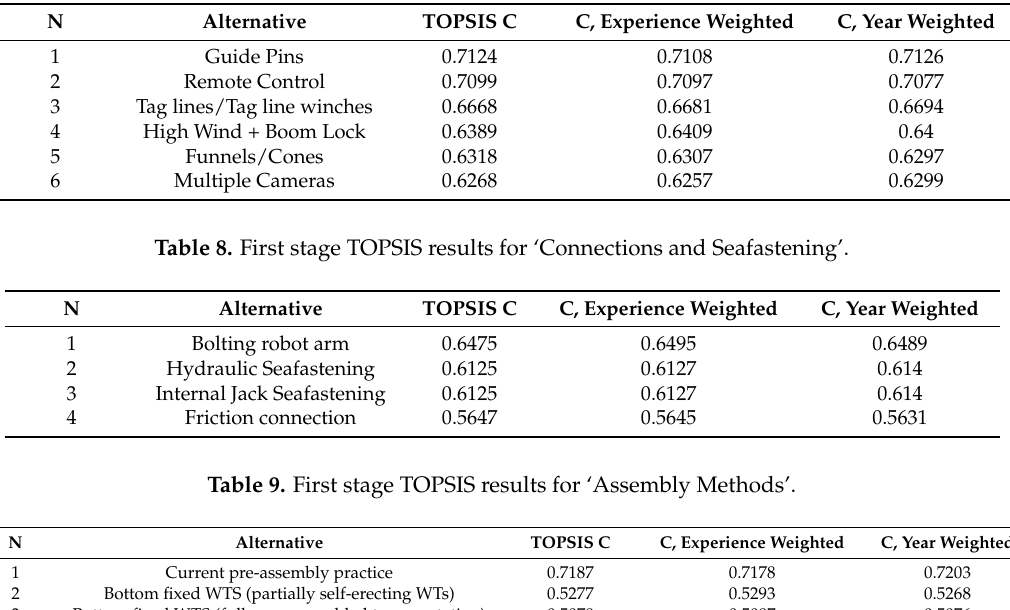
Table 7. First stage TOPSIS results for ‘Guidance and Control’.